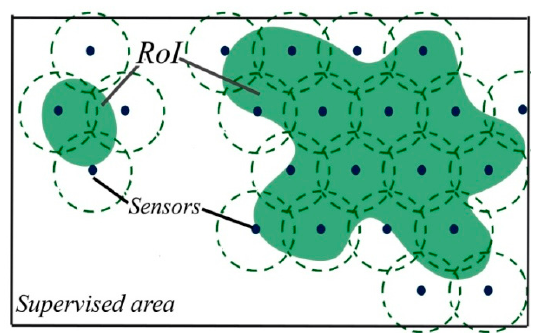
Figure 8. Topology with selected sensor nodes.